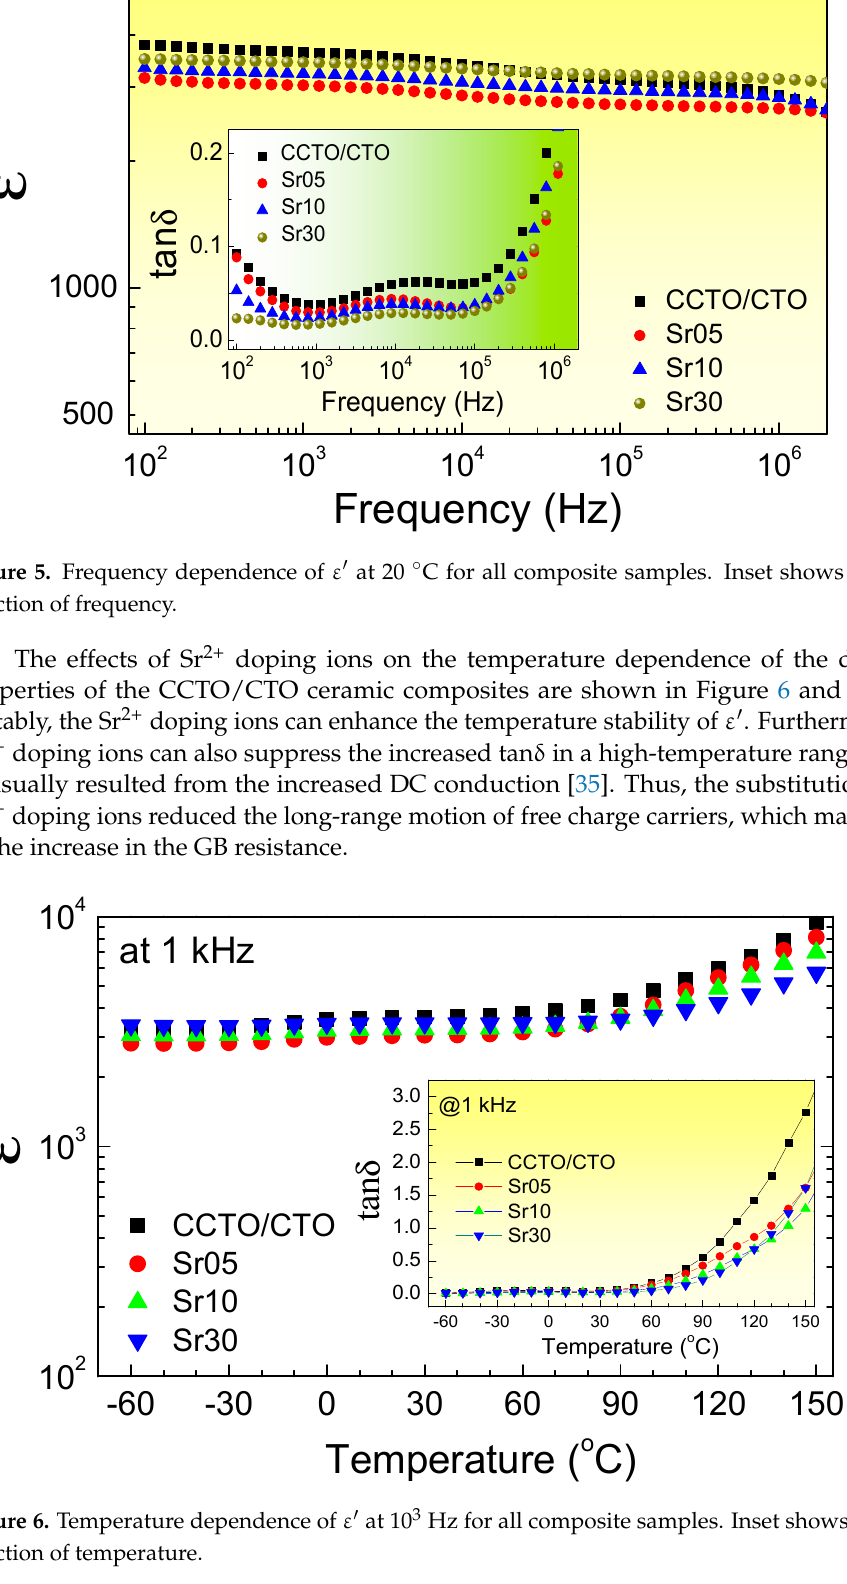
Figure 6. Temperature dependence of ε (cid:48) at 10 3 Hz for all composite samples. Inset shows tan δ as a function of Figure 6. (a) Temperature dependence of ε ′ at 10 3 Hz for all composite samples. Inset shows tan δ as a function of temper- ature. To study the electrical properties of the grains and GBs in the CCTO/CTO and Sr 2+ - doped CCTO/CTO ceramic composites, impedance spectroscopy was performed. Accord- ingly, we can estimate the capacitance (C) and resistance (R) values of electrically active grain boundaries and grain regions. M.A. Ramirez et al. [38] demonstrated that the CCTO- CTO and CCTO-CCTO interfaces were electrically active. In contrast, the CTO-CTO inter- face was inactive. Thus, the results were modeled on an ideal equivalent circuit compris- ing two parallel RC elements connected in series. The first RC element was assigned as the electrical response of semiconducting grains in the CCTO phase. The second was as- signed as the responses of the electrically active interfaces between the CCTO-CTO and CCTO-CCTO phases. Figure 7a and its inset show the impedance complex plane plots (Z*) at 80 °C and nonzero intercept at high frequencies at − 60 °C, respectively. Generally, the resistance of the grain (R g ) and GB (R gb ) at any temperature for CCTO-based polycrystal- line ceramics can be calculated from the diameters of small semicircular arc (or the non- zero intercept) and large semicircular arc in Z* plots, respectively [36]. Thus, the R g and R gb values at any temperature can be obtained. As clearly seen, R gb of the CCTO/CTO ce- ramic composites was significantly increased by doping with Sr 2+ ions, while R g decreased slightly. This result is consistent with the reduction of tan δ in a low-frequency range. Fur- thermore, the suppressed long-range motion of free charge carriers in a high-temperature range was confirmed to originate from the significant increase in R gb .